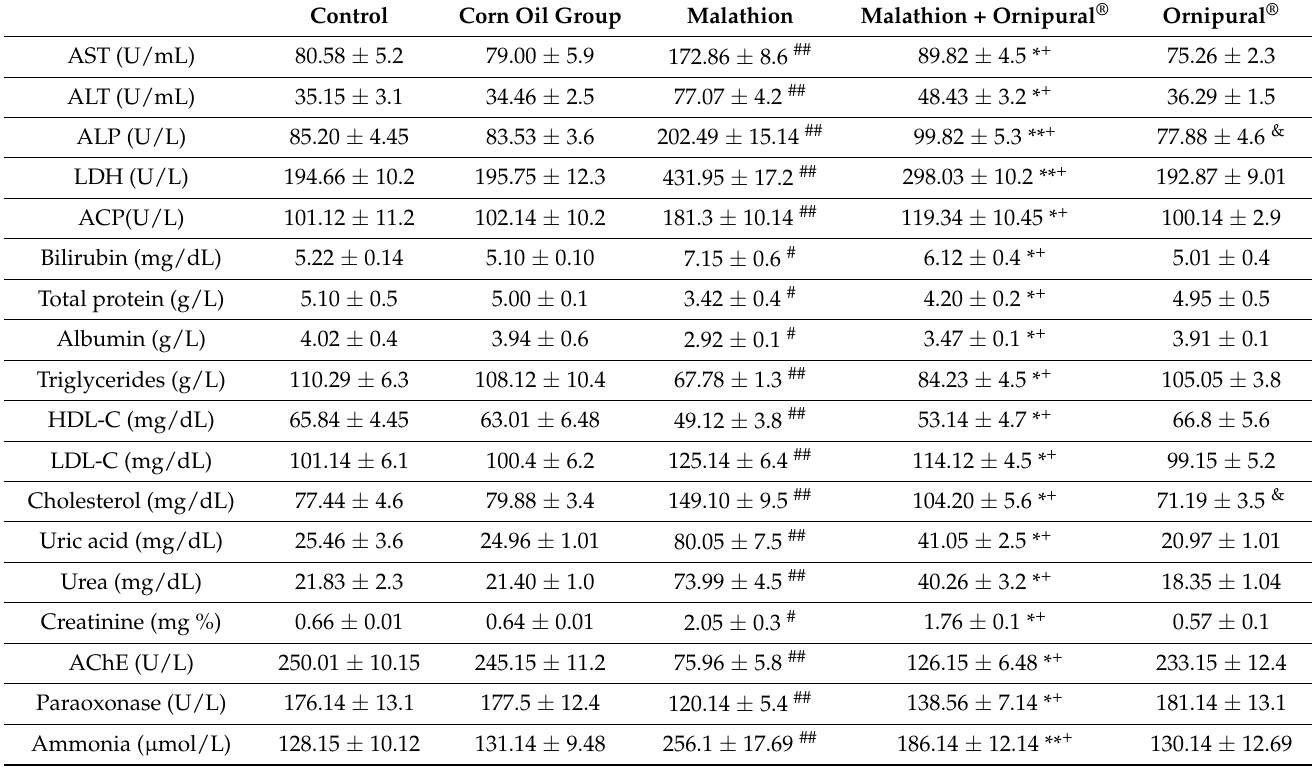
Table 3. Modulatory effect of Ornipural ® against the harmful impact of malathion on hepato-renal functional biomarkers in the